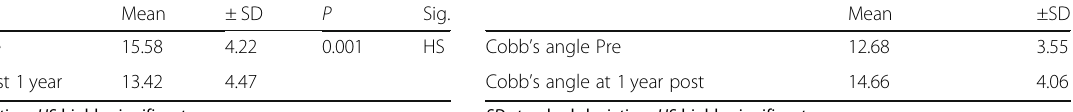
Table 3 Comparison between preoperative and postoperative Table 5 Comparison between preoperative and postoperative Cobb ’ s angle mean values among the ACDF group Cobb ’ s angle mean values among the ACDF Mean ± SD